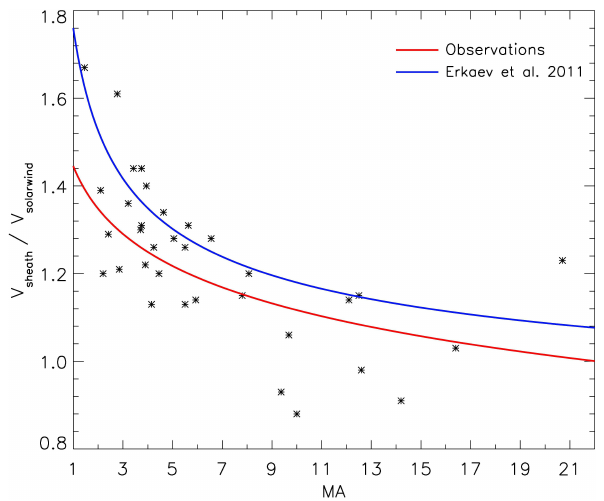
Fig. 6. The speed ratio predicted by Erkaev et al. (2011) (blue trace) against the fit to the observed data (red). A geometric fit of the form y = a 0 · x a 1 + a 2 is used for the latter. All MLTs are included, hence the scatter of points. The error bars are estimated to be small, so they are not plotted.